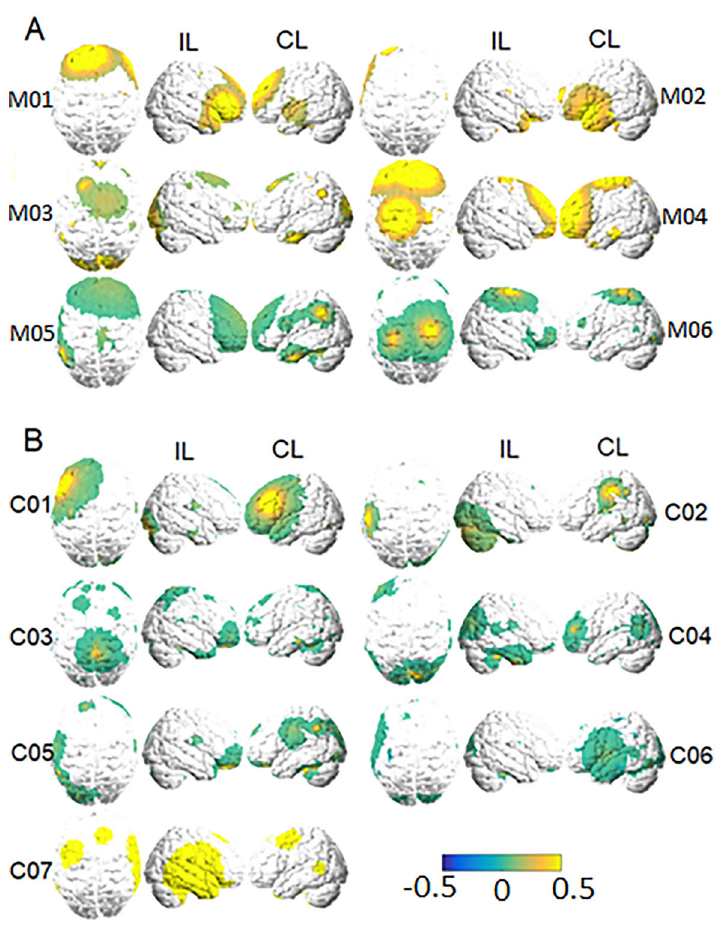
Figure 4. Individual betweenness centrality (BC) variation plots for the groups with ( A ) and without ( B ) motor-impairment. ‘ IL ’ and ‘ CL ’ indicate ‘ ipsilesional ’ (the right hemisphere) and ‘ contralesional ’ (the left hemisphere), respectively. Variations are shown in a relative color scale, according to Equation 6. Subjects from the motor stroke and control groups are labeled with ‘ M ’ and ‘ C ’ ,